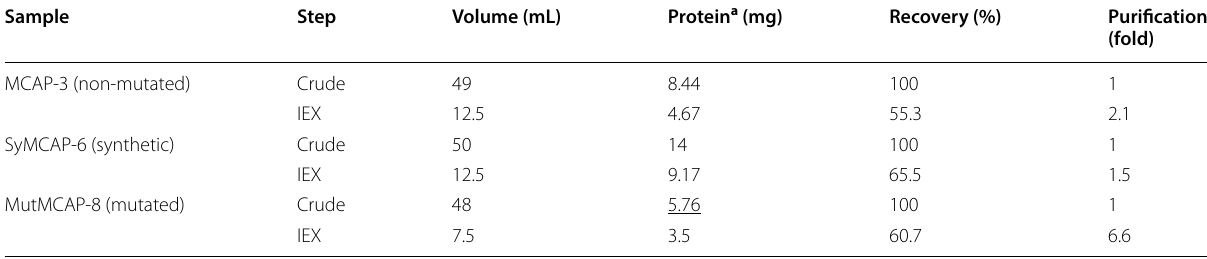
Table 3 Summary of production and purification of